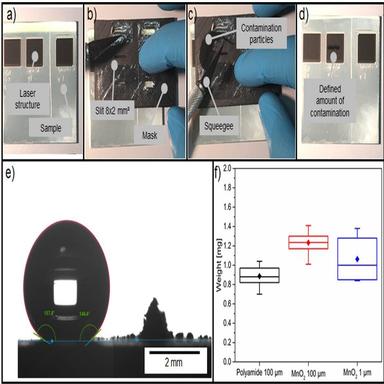
Method to position the artificial contamination precisely on the laser-structured sample. Aluminum specimen with three laser structured areas, each 10 × 10 mm2 (a), 3D-printed mask with a 8 × 2 mm2 slit is placed on the sample (b), with a squeegee a defined amount of artificial contamination is spread on the laser structured area (c), resulting in a defined trace of particles (d). Side view of 10 µl water droplet on a superhydrophobic laser-structured DLIP sample with a static water contact angle of 153° ne